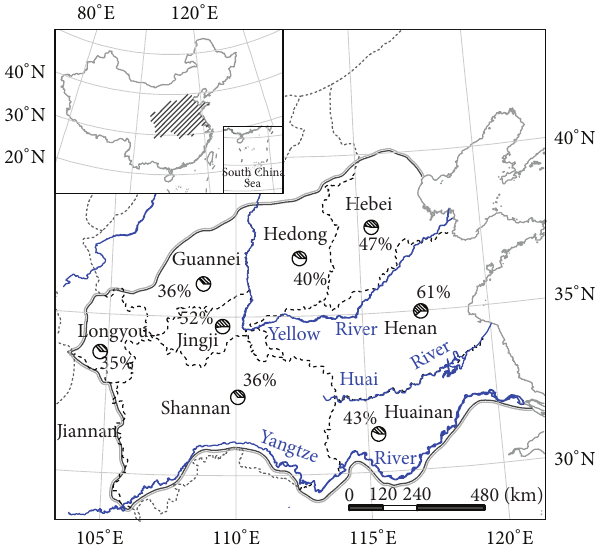
Figure 1: Study area and recorded-year fraction of each province. Shading areas in pies represent the recorded-year fraction of each province during 601–900